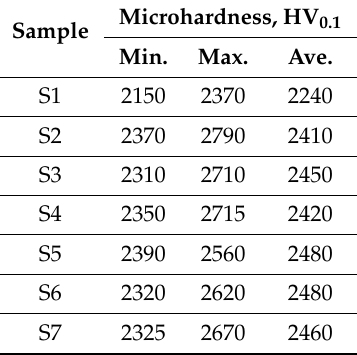
Table 3. Results of measurements of microhardness for the coatings under study.